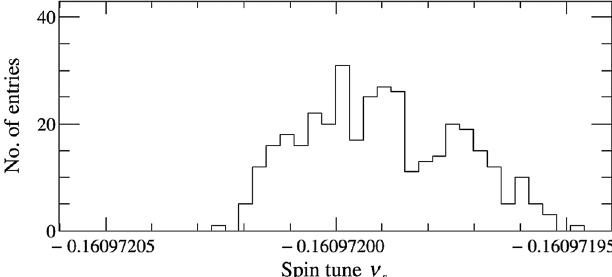
FIG. 3. Distribution of the baseline spin tunes ν interval Δ T 1 for all 359 measurement cycles, exhibiting a mean − ð 16097199 . 0 (cid:3) 1 . 6 Þ × 10 − value of h ν s 1 i ¼